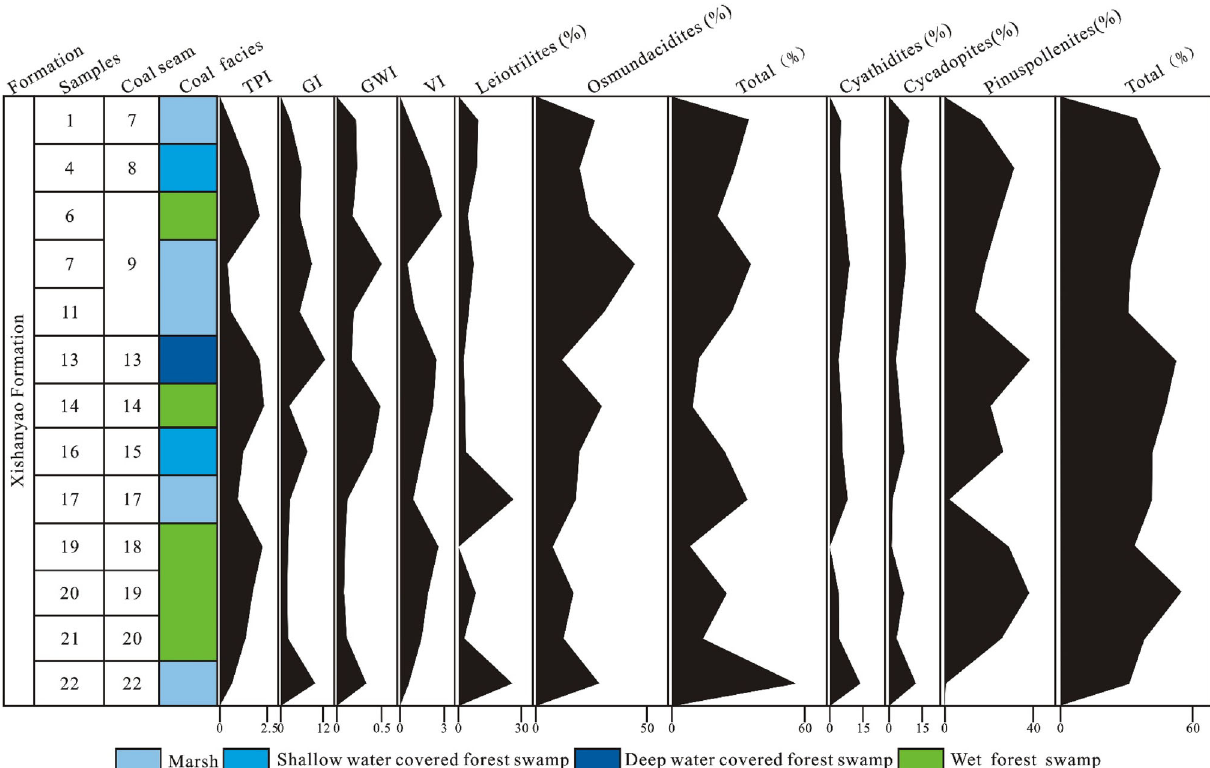
Fig. 8 The variation of coal-forming swamp parameters and sporopollens in Hanshuiquan district, Santanghu Coalfield, NW